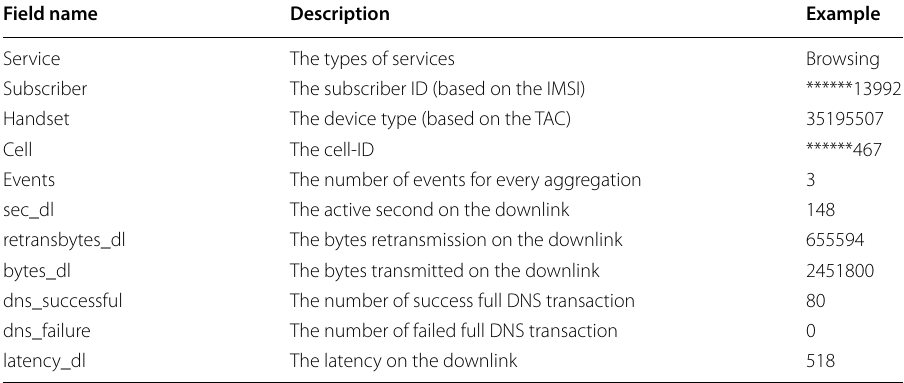
Table 2 SQM fields